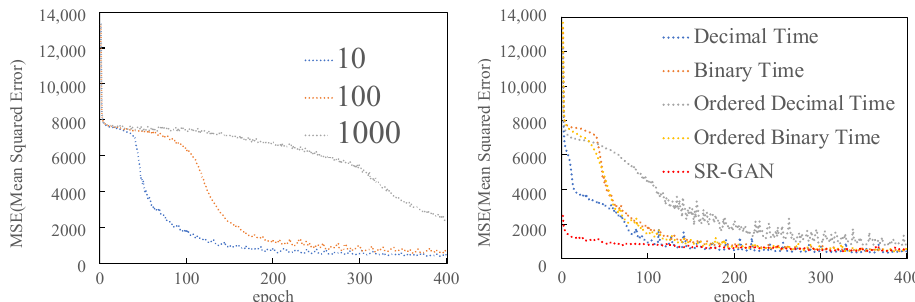
Figure 3. MSE between the generator’s output in the proposed scheme and the original traffic data for each random number and label representation against the number of